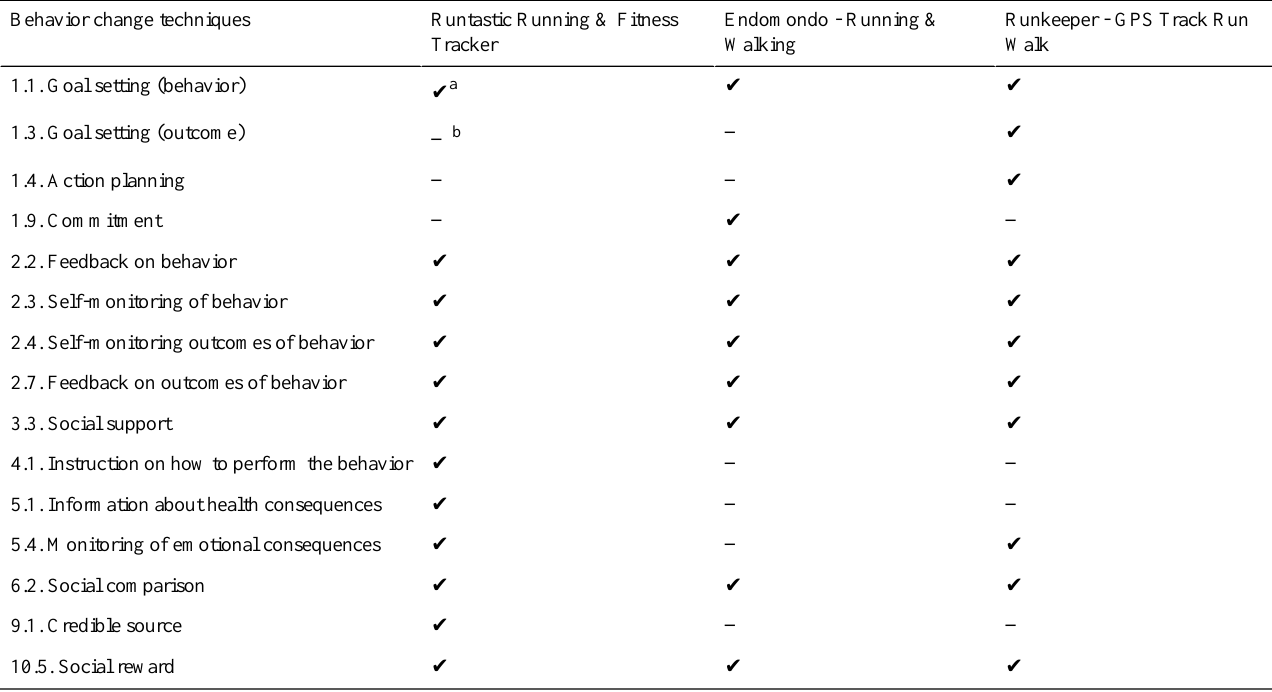
Table 1. Behavior change techniques implemented in the selected physical activity (PA) apps, coded using the behavior change technique taxonomy